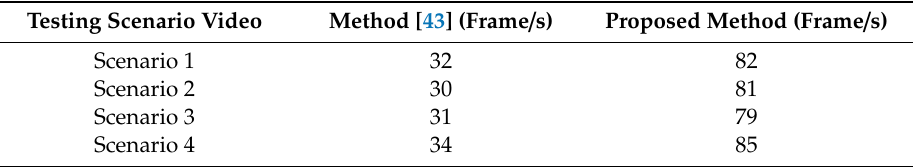
Table 1. Comparison experiment about the operating speed of the traditional method and the proposed method.